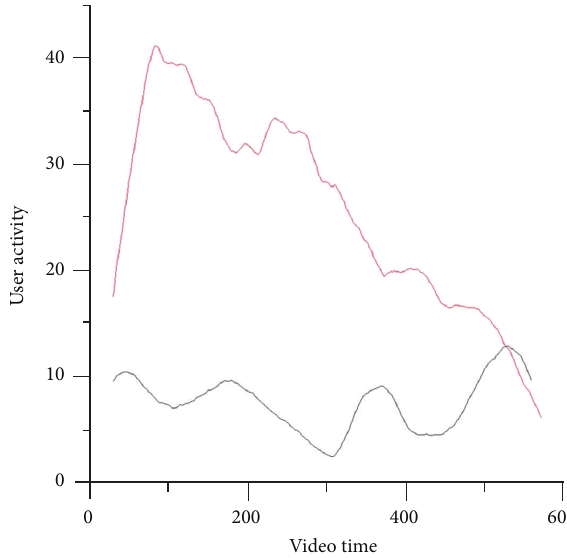
Figure 4: The Replay signal (blue, at the bottom) was compared to the Skip (red, at the top), in order to understand which one is closer to the semantics of the video. The higher values of the Skip signal stand for the popularity of the respective user